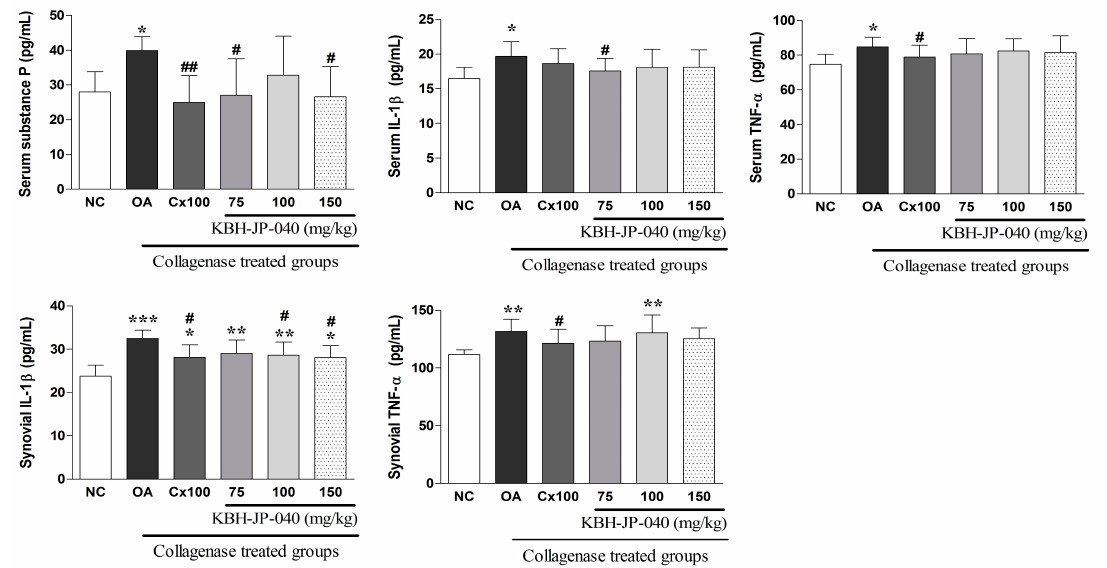
Figure 5. Effect of KBH-JP-040 supplementation on serum substance-P, serum and synovial cytokines of rabbits. NC, vehicle-treated normal control group; OA, vehicle-treated collagenase-induced osteoarthritis group; Cx100, collagenase-induced OA rabbits treated with celecoxib 100 mg/kg; collagenase-induced OA rabbits treated with standardized extract, KBH-JP-040-treated groups (75, 100 and 150 mg/kg body weight). The data are reported as means ± SD ( n = 10). *: p < 0.05; **: p < 0.01; and ***: p < 0.001, Bonferroni post hoc test following one-way ANOVA versus the NC group; #: p < 0.05; ##: p < 0.01, Bonferroni post hoc test following one-way ANOVA versus OA group.